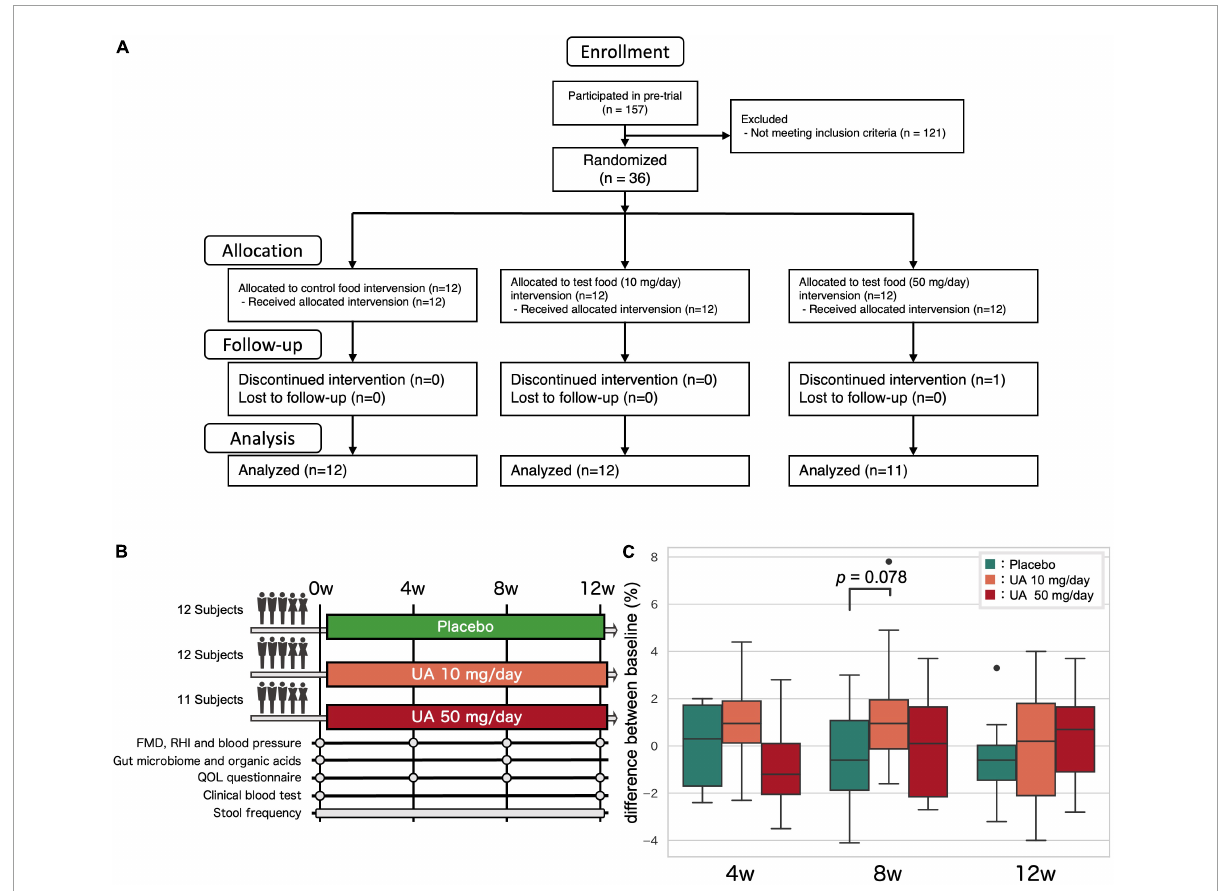
FIGURE1 Clinical trial overview. (A) Clinical trial flow diagram. (B) Overview of the clinical trial. Fecal samples were collected at the 0, 4, 8, and 12 weeks and analyzed at 0 and 8 weeks. (C) The effect of UA on the FMD. P -values for the groups that showed an increasing trend compared to